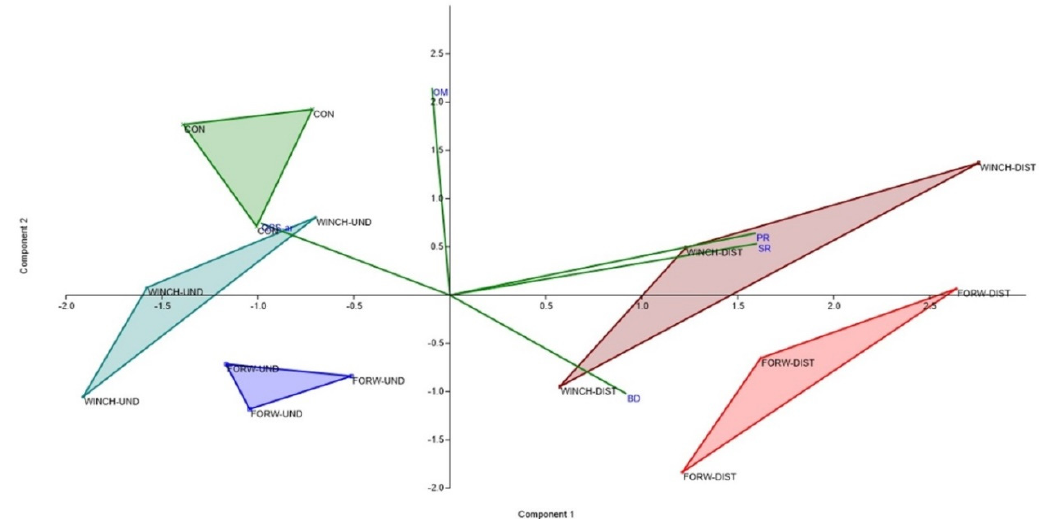
Figure 7. Score plot of components PC1 and PC2 of the principal component analysis referred to the investigated soil variables. Control area is reported in green; WINCH-UND in light blue; FORW-UND in dark blue; WINCH-DIST in dark red and FORW-DIST in light red. Green lines indicate the